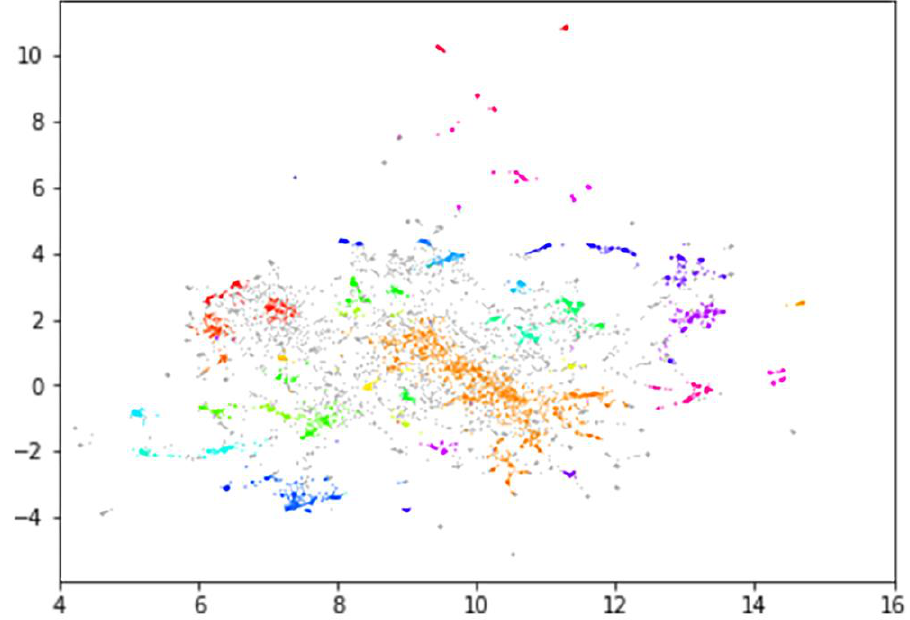
Figure 3. UMAP-reduced 2D vectors representing the questions. The colored dense areas are the documents that the HDBSCAN interpreted as clusters of different prominent topics, and the grey points are the documents labelled as outliers and do not belong to any cluster.